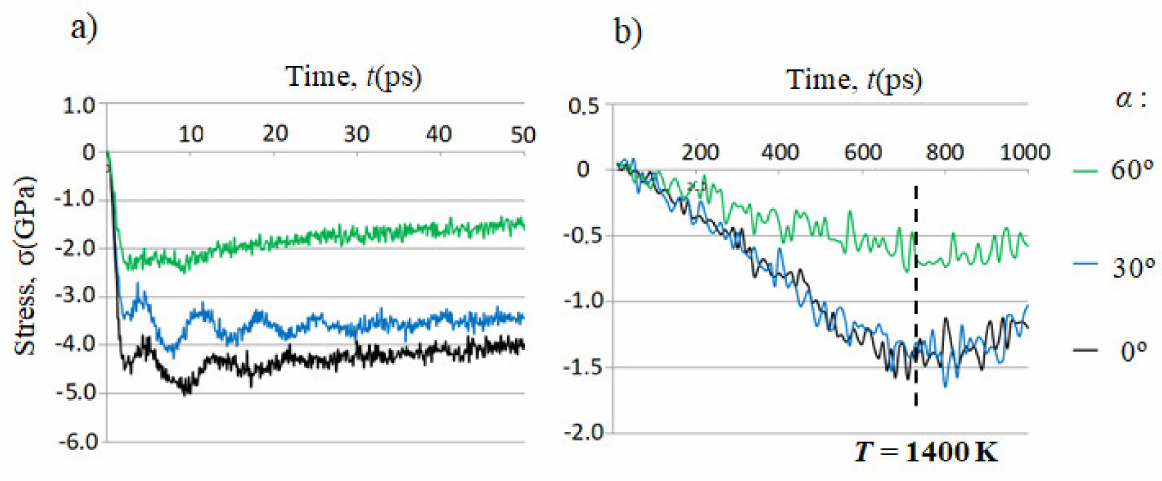
Figure 4. Heating-induced stresses in high-energy-deposited silicon dioxide films. Energy of the incoming silicon atoms E(Si) = 10 eV, α is the deposition angle, τ is the heating time, ( a ) τ = 1 ps; ( b ) τ = 1 ns. Heating temperature T f = 1700